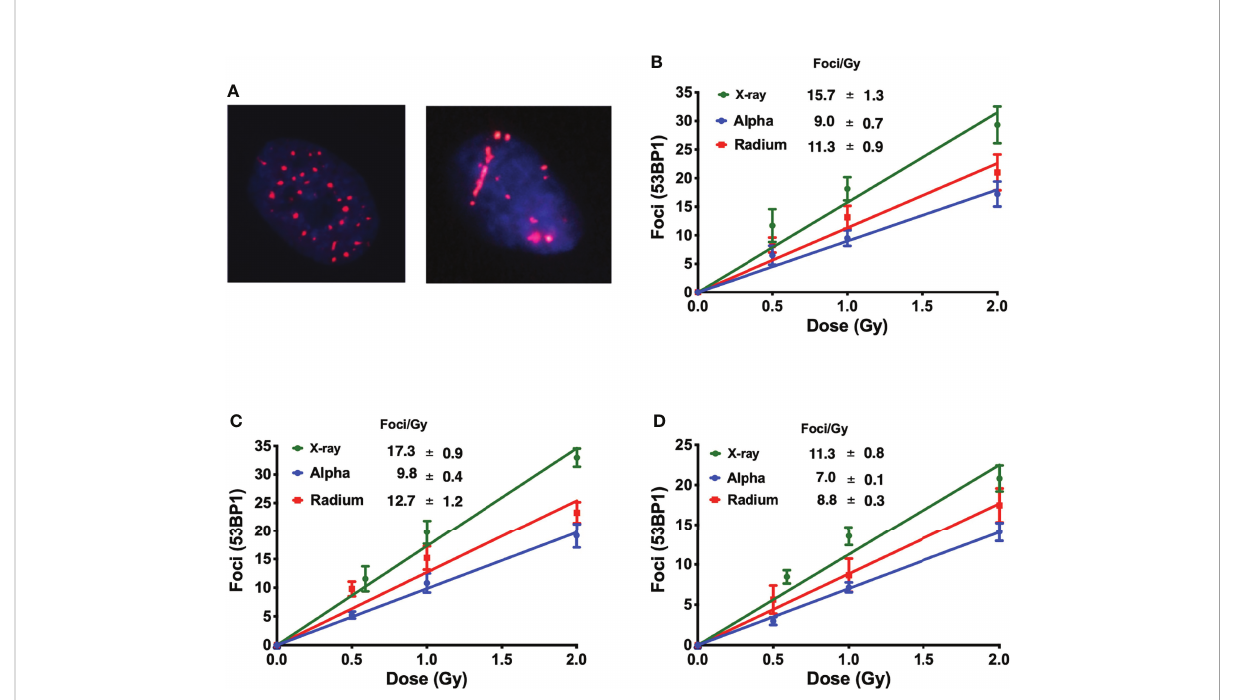
FIGURE 2 (A) Different ionization patterns visualized by immuno fl uorescence staining for 53BP1 in the nucleus of U2OS cells 1 h after exposure to 1 Gy of X-rays (left) and 223 Ra (right). The average number of 53BP1 foci per cell induced 1 h after exposure to X-rays or external alpha particles or 24-h exposure to 223 Ra for (B) PC-3, (C) U2OS, and (D) RWPE. Points represent the mean of three independent experiments and the respective standard error; all values are background-corrected for the average of foci in control